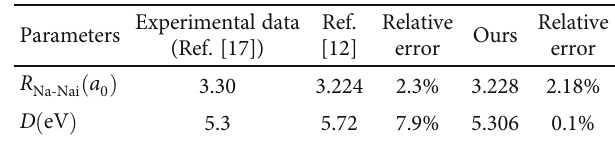
3D potential energy (au.) for Na2F